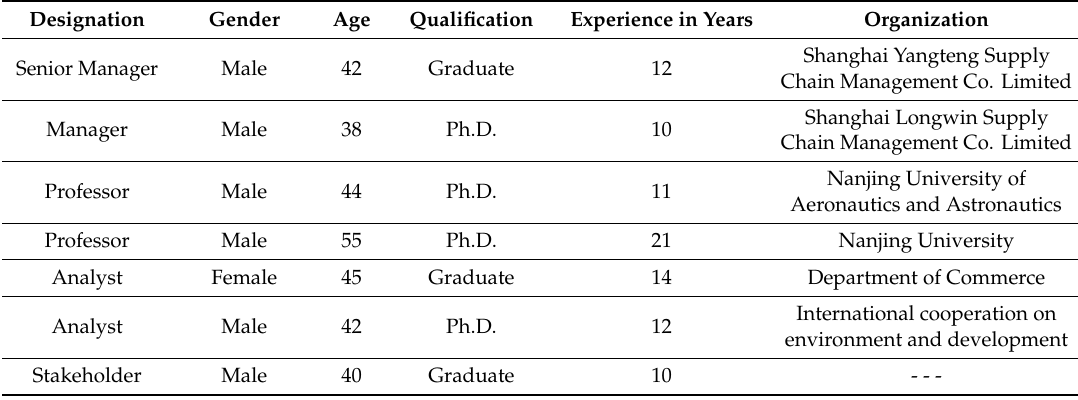
Table A5. Demographic information of experts.